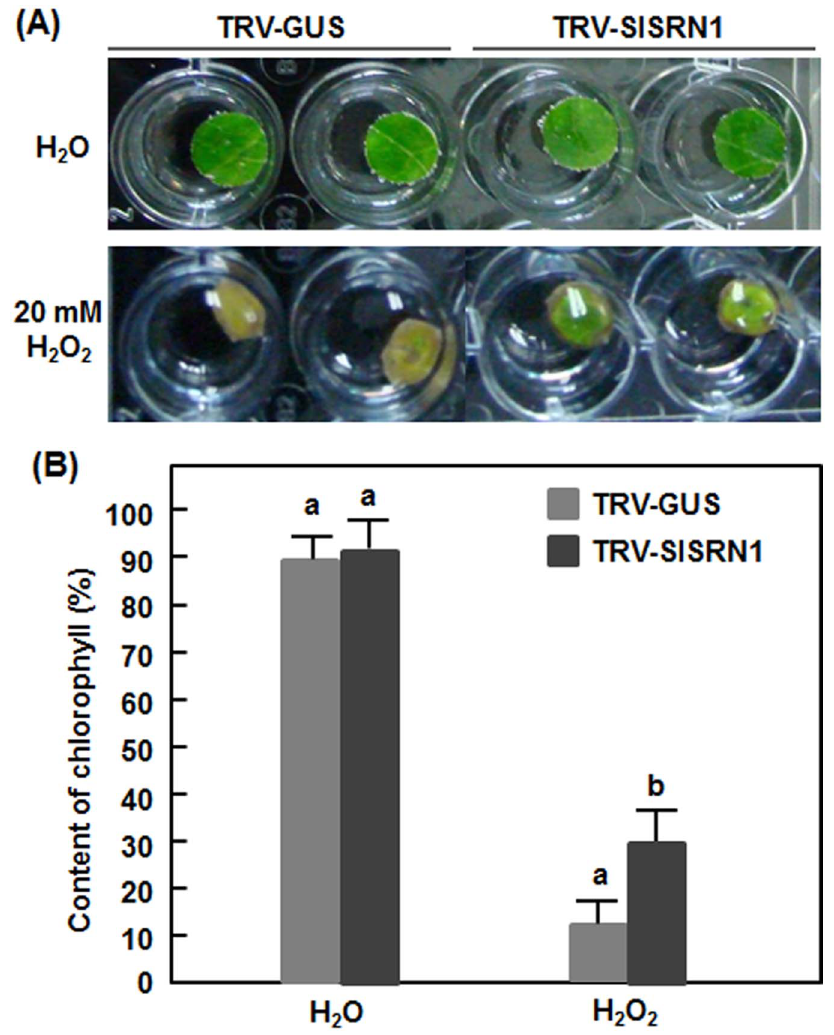
Figure 7. Silencing of SlSRN1 increased tolerance to oxidative stress. Two-week-old seedlings were infiltrated with agrobacteria carrying TRV-SlSRN1 or TRV-GUS and leaf discs were taken from leaves of TRV-SlSRN1- or TRV-GUS-infiltrated plants at 2 weeks after VIGS infiltration. Leaf discs were soaked in 1/2 MS buffer supplemented with 20 mM H 2 O 2 or H 2 O (as a control). Phenotype (A) and relative chlorophyll contents (B) in leaf discs from TRV-SlSRN1- or TRV-GUS-infiltrated plants under oxidative stress. Photos and samples for analysis of chlorophyll contents were taken at 5 days after treatment. Data presented in (B) are the means 6 SD from three independent experiments and different letters above the columns indicate significant differences at p , 0.05